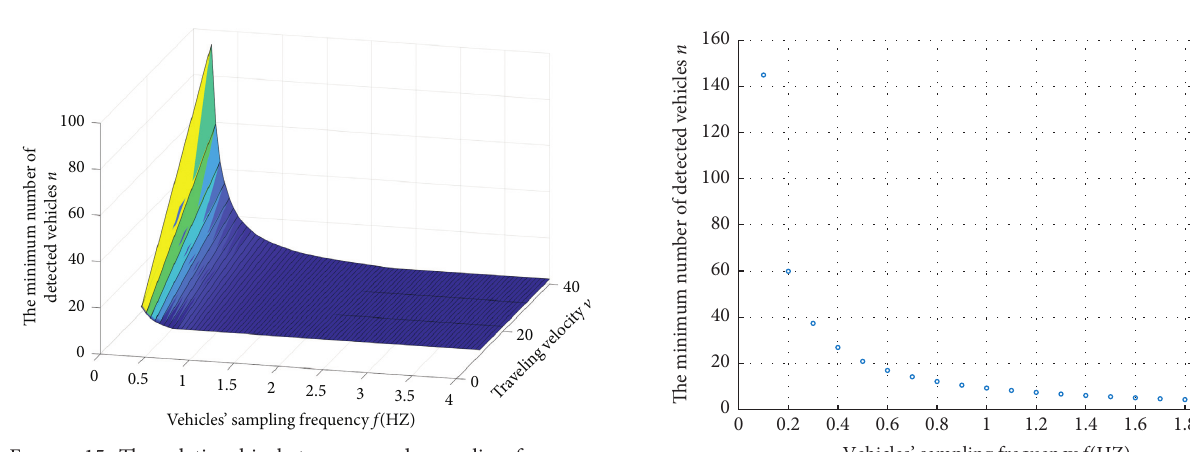
Figure 15: The relationship between speed, sampling frequency, and the minimum number of vehicles. Figure